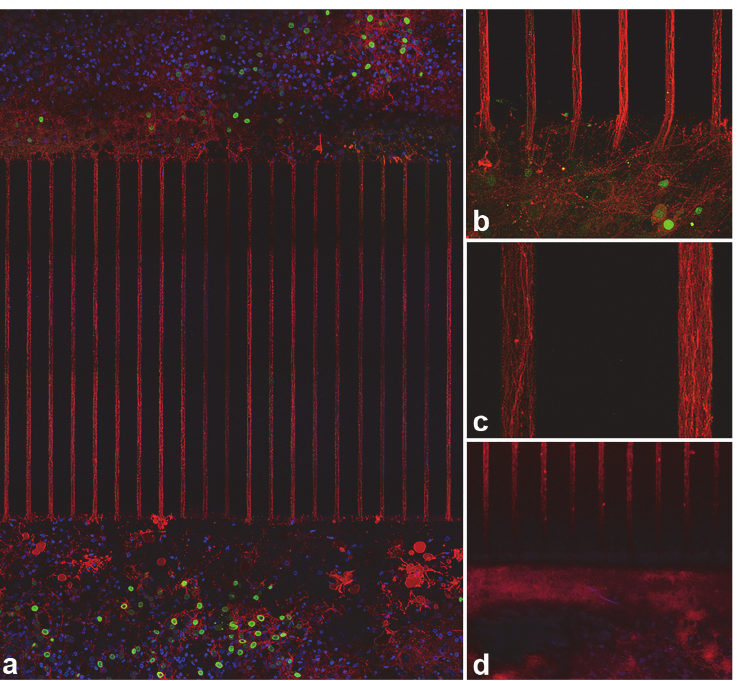
Fig 3. Putative axons, infected with adeno-associated viruses (AAVs), grew through channels. Some neurons were infected with an AAV carrying green fluorescent protein and are shown in green and the cell membrane was infected with an AAV carrying tdTomato and are shown in red. Additional DAPI (dsDNA stain) immunostaining in a and c is in blue. (a) Fixed overview of channels and chambers, (b) Zoomed in, live cell image showing processes growing into channel, (c) Further zoom into channels near middle, (d) Fixed cells on chip imaged through 0.7 mm of poly(dimethylsiloxane).